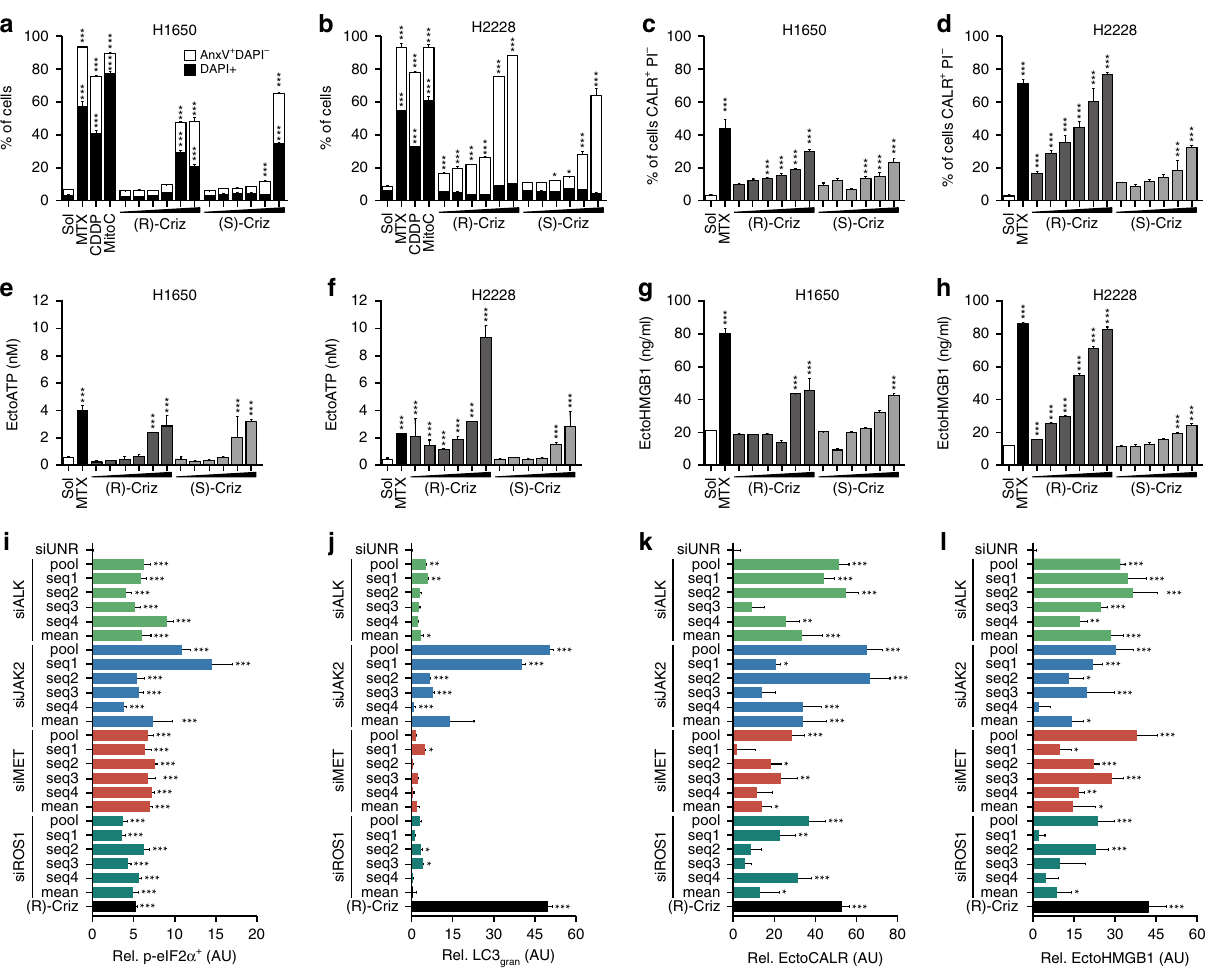
Fig. 2 Mode of action of (R)-crizotinib induced ICD. a – h Investigation of crizotinib induced ICD in the NSCLC cell lines, NCI-H2228 and NCI-H1650, which are positive and negative for the EML4-ALK fusion protein, respectively. H1650 (EML4-ALK − ) and H2228 (EML4-ALK + ) cells were treated with mitoxantrone (MTX; 2 µ M), or increasing concentrations (0.1, 0.5, 1, 2.5, 5, 10 µ M) of (R)-crizotinib or (S)-crizotinib (Criz) for 72h to assess cell death using AnnexinV, DAPI staining ( a , b ), and 24h to determine immunogenic cell death parameters ( c – h ). i – l SiRNAs knockdown of crizotinib targeting kinases induces ICD similar to crizotinib. Indicated siRNAs (a pool of four siRNA duplexes or 4 individual sequences) were reversely transfected into U2OS cells or their derivatives stably co-expressing calreticulin (CALR)-RFP and HMGB1-GFP or GFP-LC3. Forty-eight h later the phosphorylation of eIF2 α and other ICD hallmarks (CALR- RFP redistribution, GFP-LC3 granularity and HMGB1-GFP intensity) were assessed. Treatment of unrelated-siRNA-transfected cells with (R)-crizotinib for 24h was used as a positive control. The capacity of siRNA-mediated knockdowns to induce ICD parameters was normalized to unrelated-siRNA-transfected cells. Data are shown as mean ±s.e.m. ( n = 3; * p < 0.05, ** p < 0.01, *** p <0.001, compared to unrelated siRNA using Student ’ s t